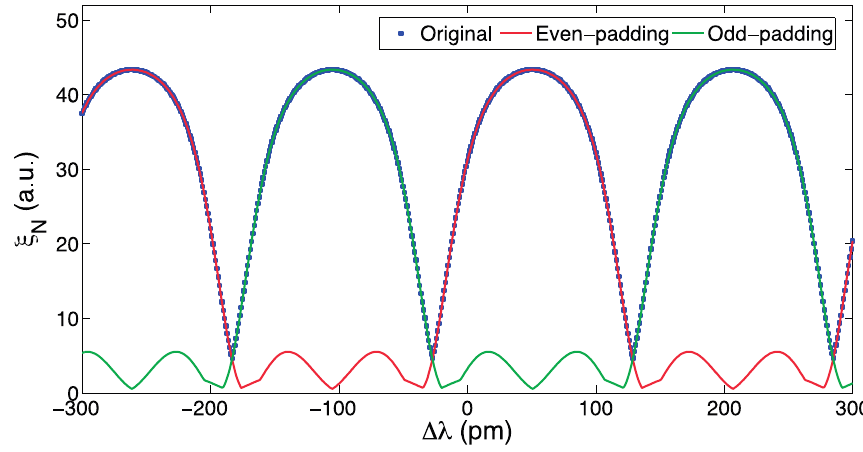
Figure 5. ξ N ( Δλ ) function reported for all spectral values as in Figure 4, and padding to zero all even and odd samples input to the FFT in Equation